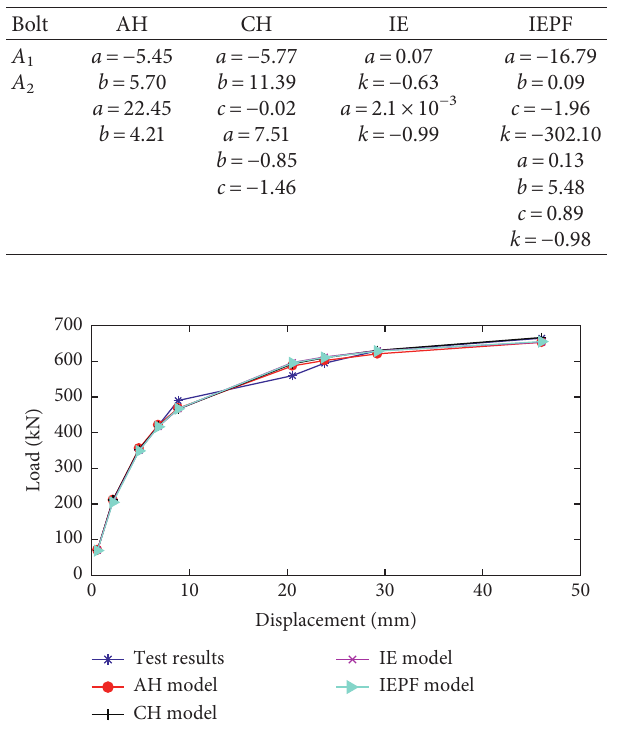
Figure 3: Comparison of each model with the test data from A